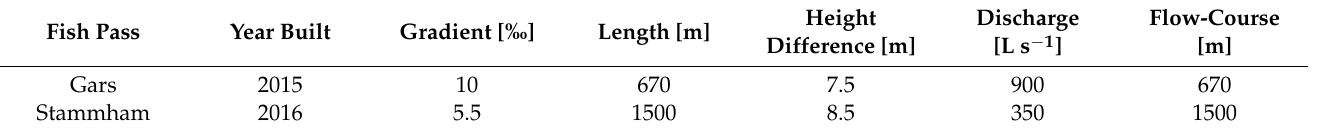
Table 1. Construction details of the two assessed fish passes Gars and Stammham.